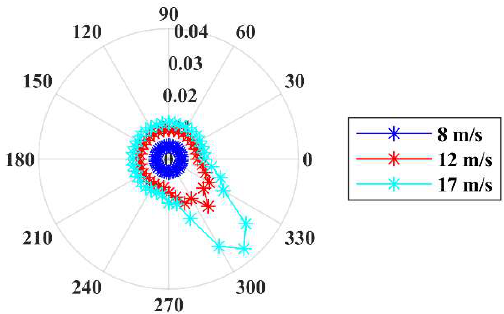
Figure 9. Probability of variable wind speeds and variable wind directions.